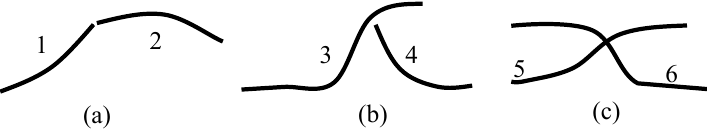
Figure 3. Basic modes of crack linking. ( a ) meeting; ( b ) merging; ( c )